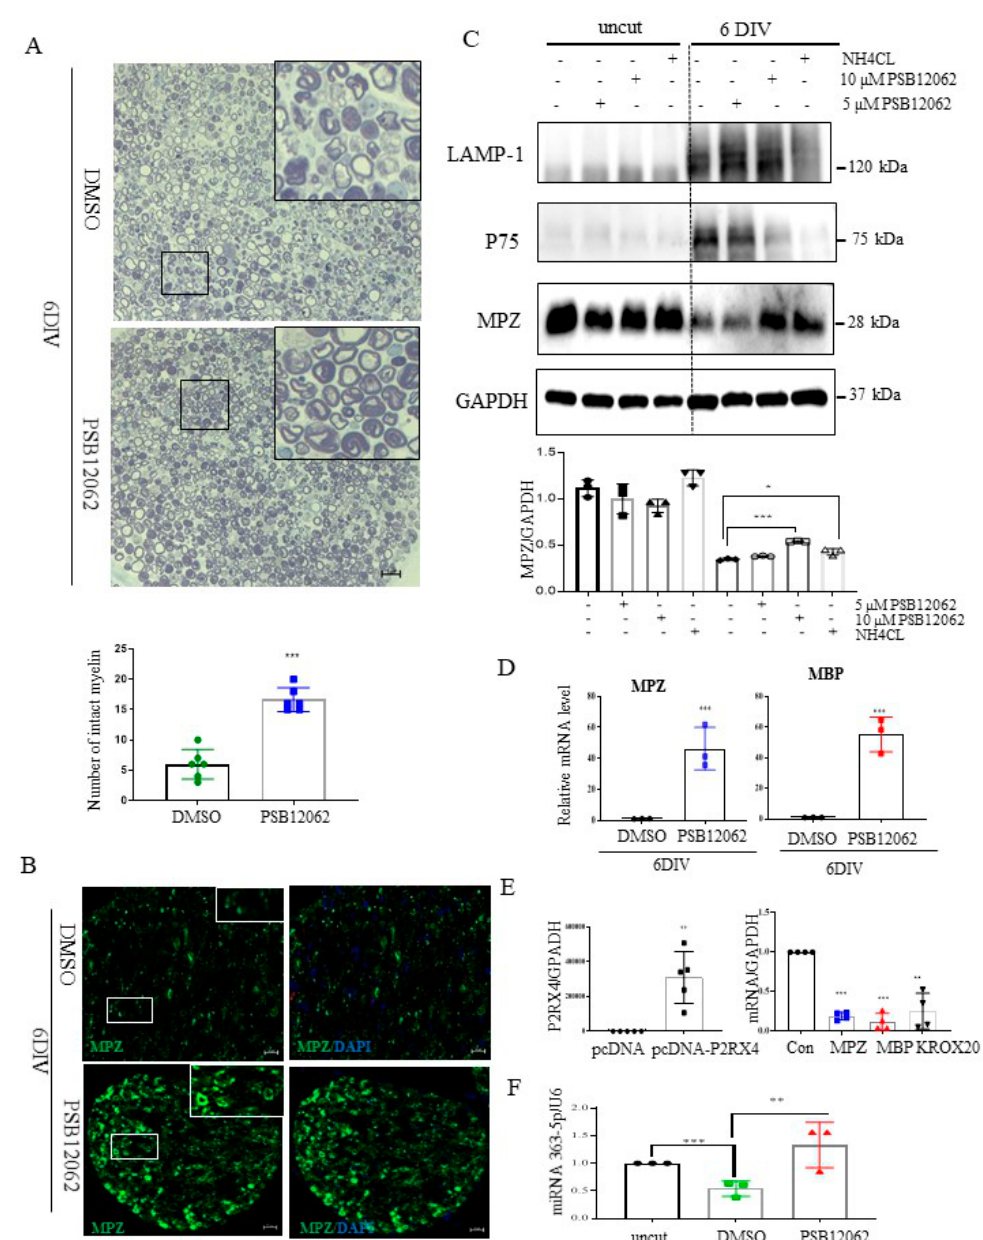
Figure 5. Sciatic nerve explants cultured for 6 DIV after P2RX4 antagonist treatment exhibited myelination upregulation. ( A ) Representative images of semithin sections showing that P2RX4 antagonist treatment (PSB12062) blocked the degradation of myelin proteins in nerve segments maintained for 6 DIV. Scale bar = 20 µ m. The lower panel shows the number of intact myelin layers. n = 6. ( B ) Immunofluorescence analysis showing that the P2RX4 antagonist PSB12062 (10 µ M) prevented the degradation of MPZ (green). Myelin was stained with MPZ (green, left panel ) and nuclei with DAPI (blue, right panel ). Scale bar = 50 µ m. ( C ) Western blot showing that PSB12062 blocked degradation of the myelin protein MPZ in nerve segments maintained for 6 DIV. Uncut indicates freshly isolated nerves. Western blotting was carried out for LAMP1, p75, MPZ, and GAPDH. The lower panel shows the Western blot results. n = 3. ( D ) RT-qPCR analysis of MPZ and MBP mRNA levels in nerve segments maintained for 6 DIV treated with PSB12062, compared with the untreated control. Data are mean ± SD (error bars). n = 3. ( E ) Overexpression of P2RX4 by pcDNA-P2RX4-DYKDDDDK tag plasmid increased the MPZ, KROX20, and MBP levels. Left, level of P2RX4 after transfection with pcDNA or pcDNA-P2RX4-DYKDDDDK-tagged plasmid. n = 5. Right, levels of MPZ, KROX20, and MBP. n = 4. ( F ) RT-qPCR analysis of miRNA 363 − 5p expression in nerve segments maintained for 6 DIV and treated with PSB12062, compared with the untreated control. Uncut indicates freshly isolated nerves. n = 3. Data are the mean ± SD. * p < 0.05, ** p < 0.01, *** p <